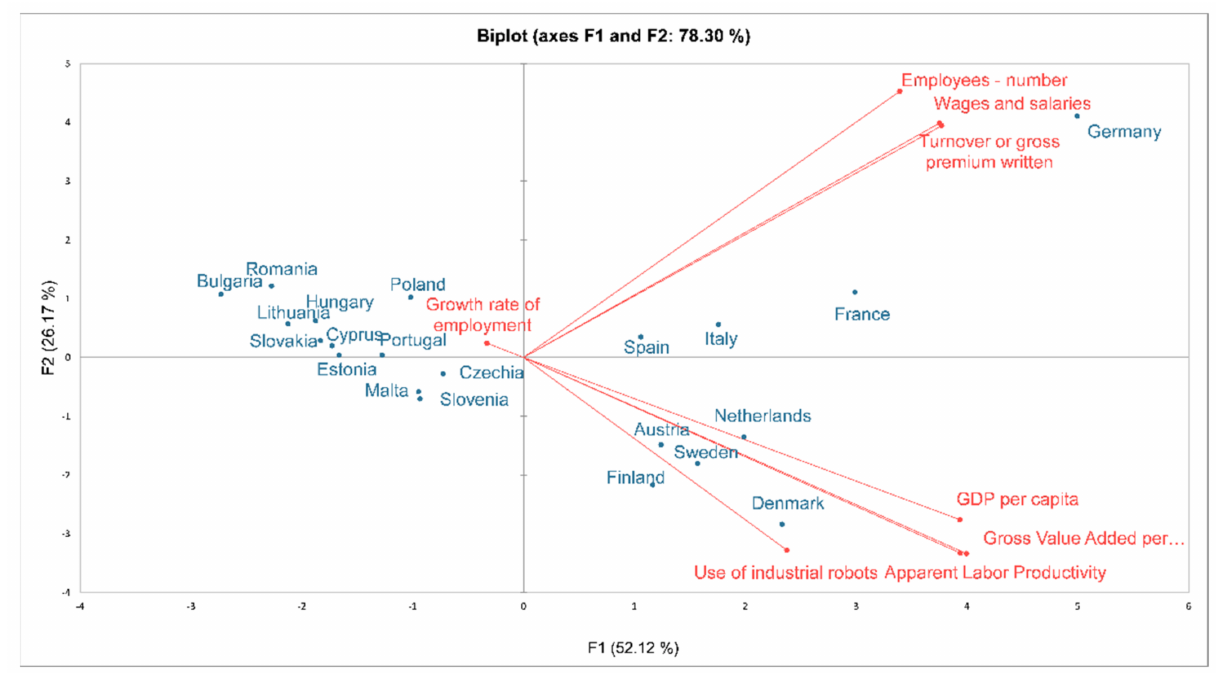
Figure 13. Biplot on F1 and F2—countries distribution pattern. Source: Author’s contribution based on data retrieved from Eurostat. Annual enterprise statistics for special aggregates of